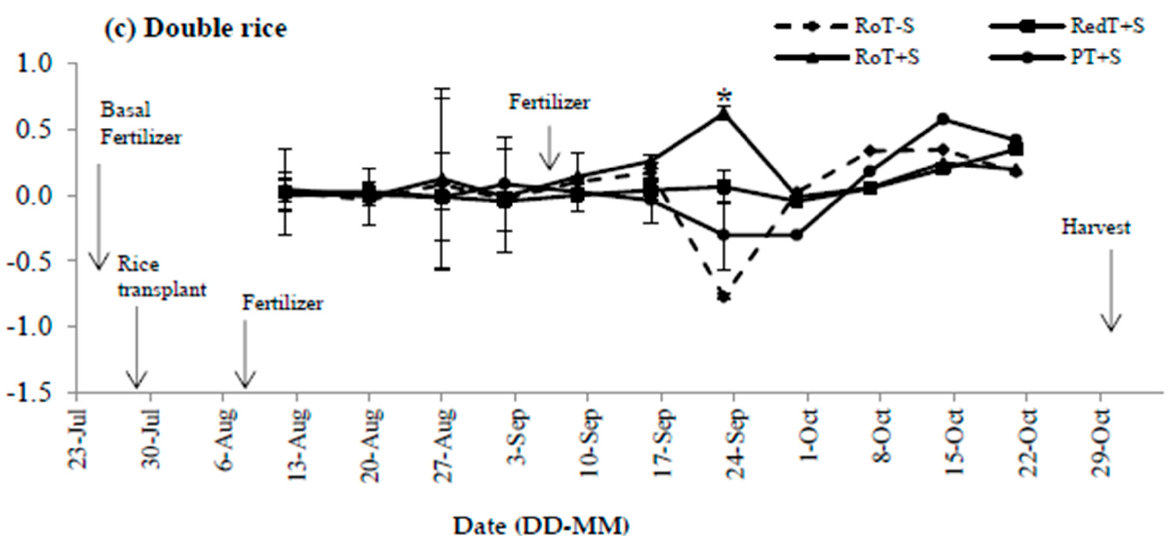
Figure 4. Impacts of straw incorporated tillage patterns on N 2 O fluxes in the three cropping systems. PT − S indicates plough tillage + no straw, RoT − S indicates rotary tillage + no straw, RedT + S indicates reduced tillage + straw, RoT + S indicates rotary tillage + straw; PT + S indicates plough tillage + straw. Since the baseline of soil tillage was different, PT − S and RoT − S were respectively implemented as the control in different test sites. * indicates a significant difference at 0.05 probability level in each cropping system.